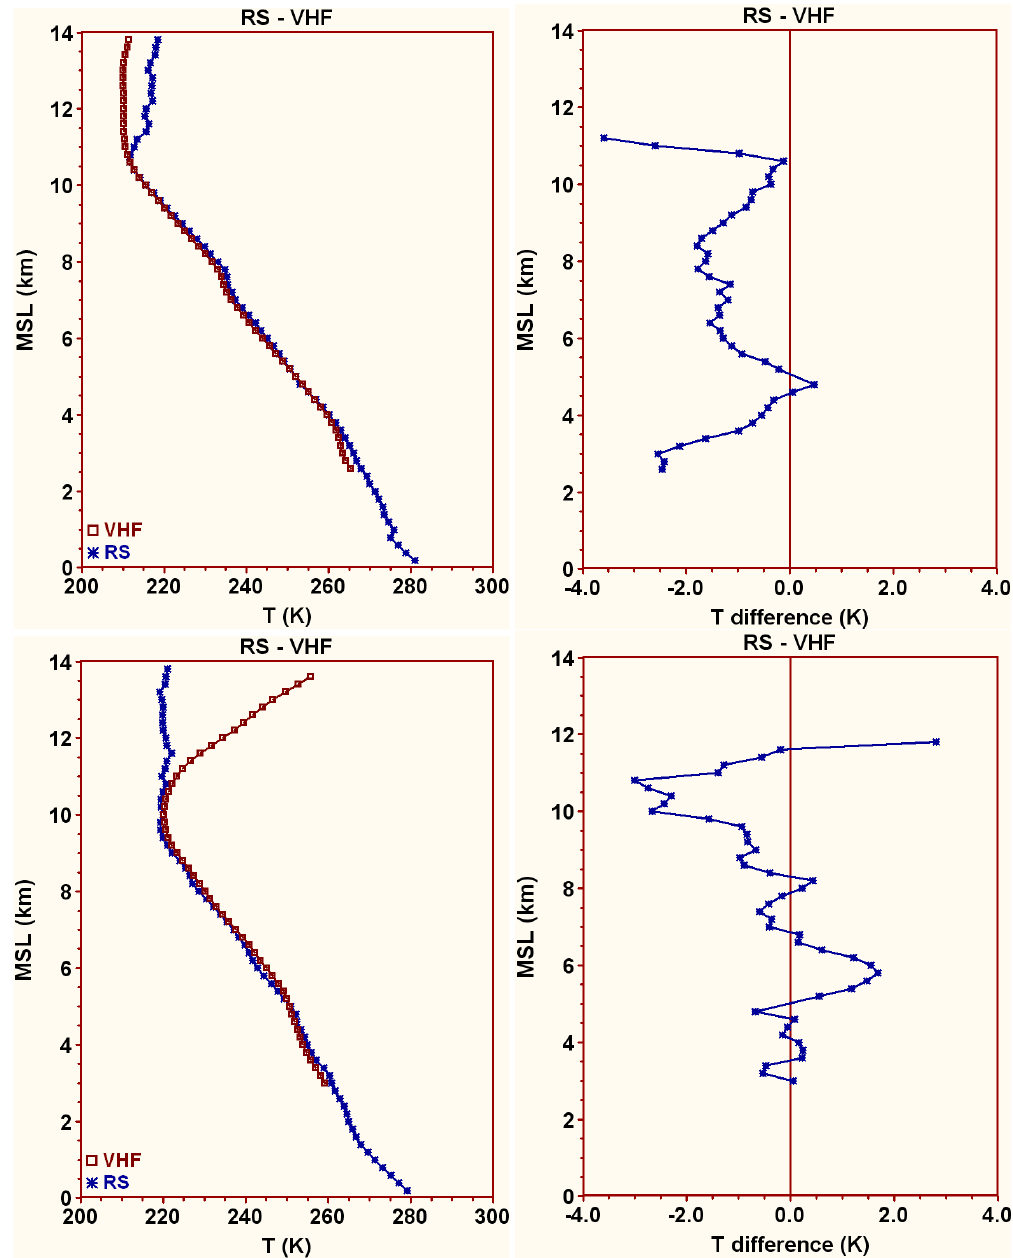
Fig. 12. Comparison of T between radio soundings (RS) and VHF radar (VHF) using the B-V frequency calculation through the vertical speed spectra (Left: Absolute values, right: Temperature differences). The starting point at the 5km range gate has been extracted from the RS